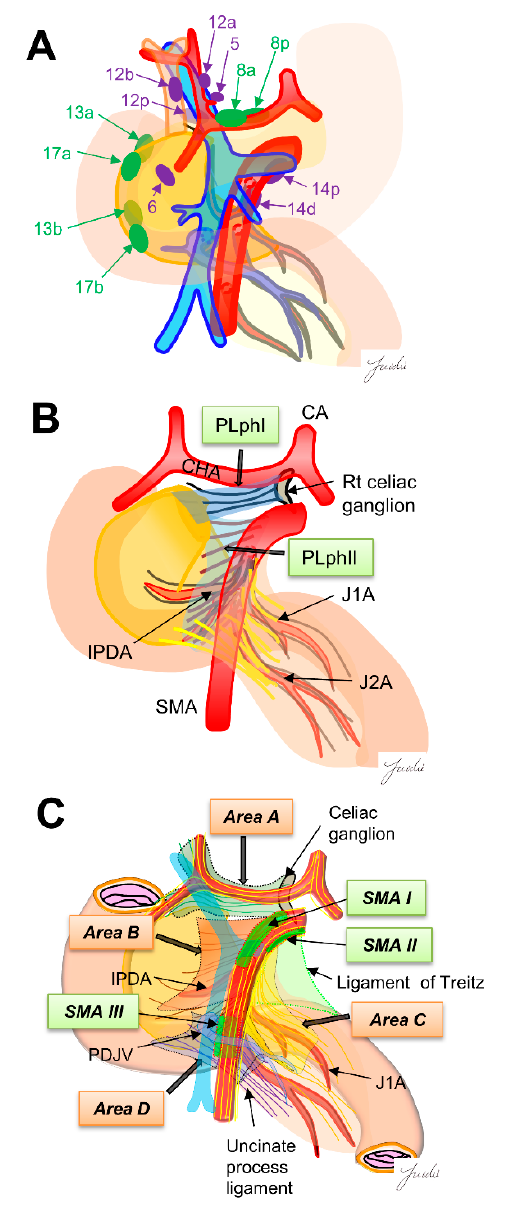
Figure 1. ( A ) The regional lymph nodes are numbered according to the Japanese Pancreatic Cancer classification. Green, D1 region, purple, D2 region. ( B ) Extra-pancreatic nerve plexus around the SMA nerve plexus in the Japanese pancreatic cancer classification. ( C ) Intensive NFTs spreading around the SMA are classified into four areas. Nagakawa et al. [16] classified “intensive NFTs” around the pancreatic head into areas A–D. They also found the three SMA regions (SMAI-III) that can be easily exposed. These regions become anatomical landmarks as “dissection-guiding points” to uniformly dissect each area A–D. PLphI, pancreatic head nerve plexus I; PLphII, pancreatic head nerve plexus II; CA, celiac artery; CHA, common hepatic artery; SMA, superior mesenteric artery; IPDA, inferior pancreaticoduodenal artery; J1A, first jejunal artery; J2A, second jejunal artery; PDJV, proximal dorsal jejunal vein.